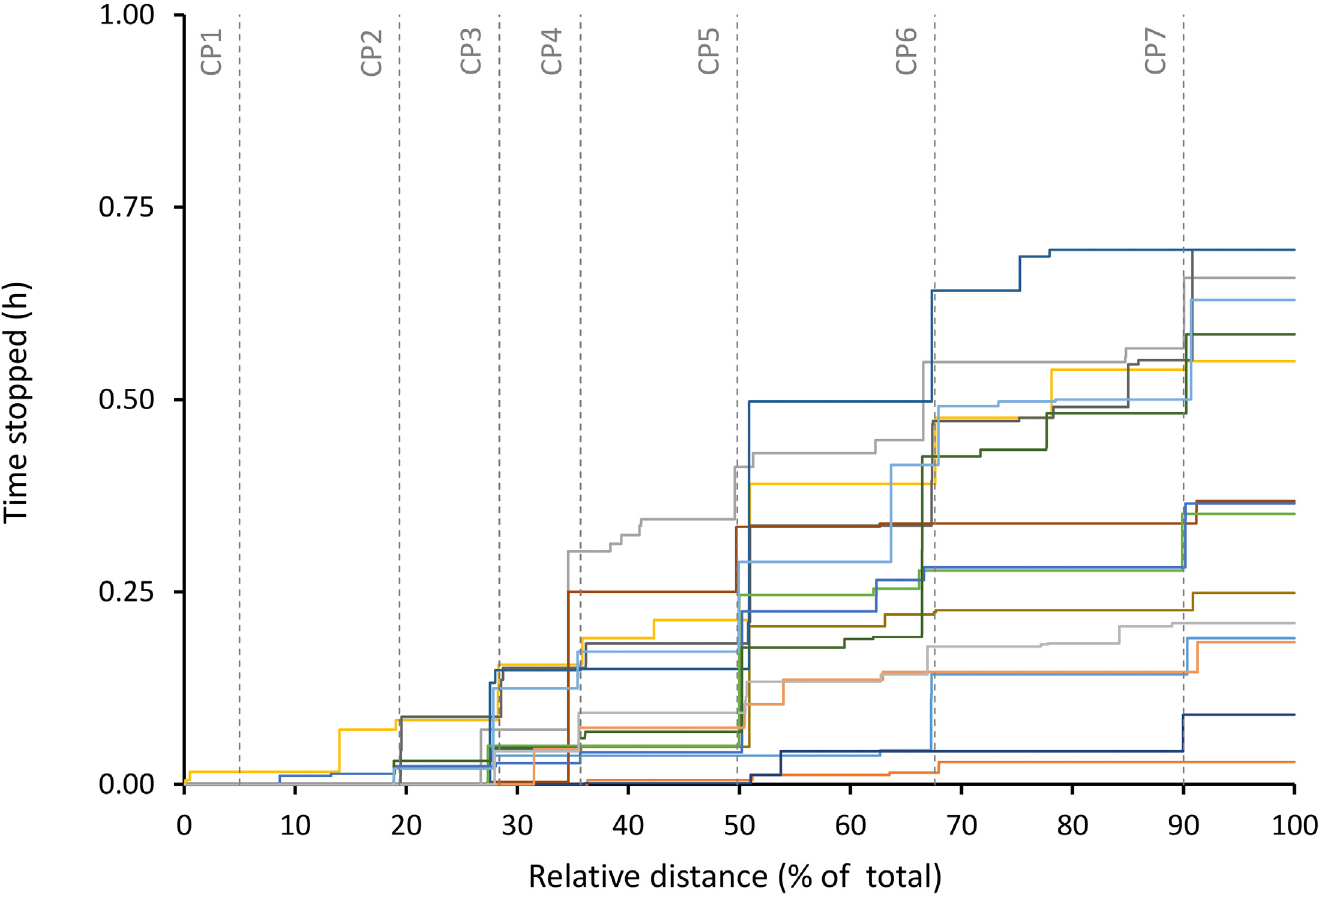
Fig 1. Total time stopped. Total time stopped for each participant, including the relative position of official event checkpoints. “ CP ” are official event checkpoints. CP 1 and 6: distance ~7 km (outbound) and ~69 km (inbound), altitude ~1015 m. CP 2: distance ~ 19 km, altitude ~815 m. CP 3 and 5: distance ~29 km (outbound) and ~52 km (inbound), elevation ~1160 m. CP 4: distance ~36.5 km, elevation ~1699 m. CP 7: distance ~93 km, elevation ~1263